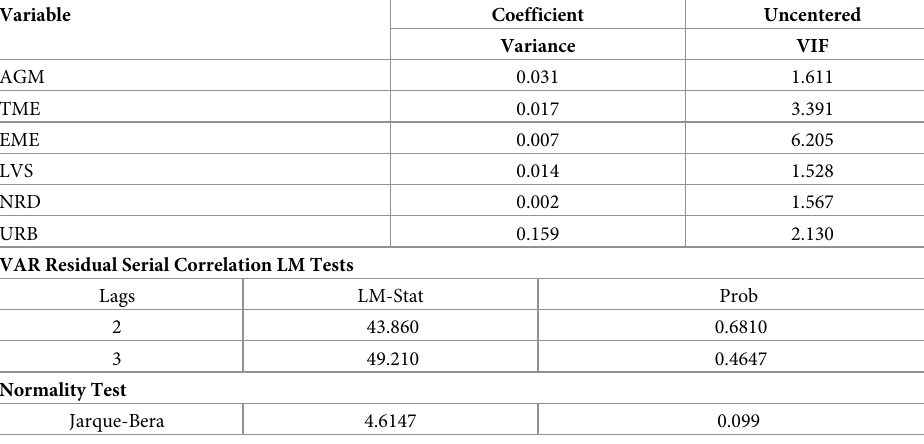
Table 10. Multicollinearity, normality, and autocorrelation test